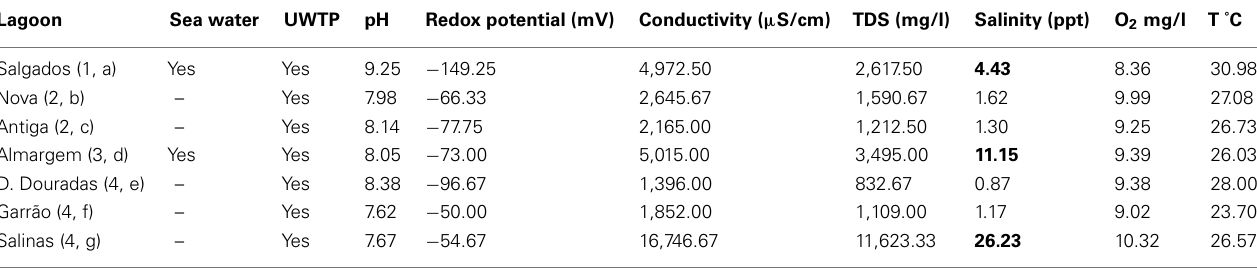
Table 1 | Physical and chemical parameters* of the seven lagoons surveyed, communication with sea water and effluents of urban wastewater treatment plants, represented as the mean value for the observational